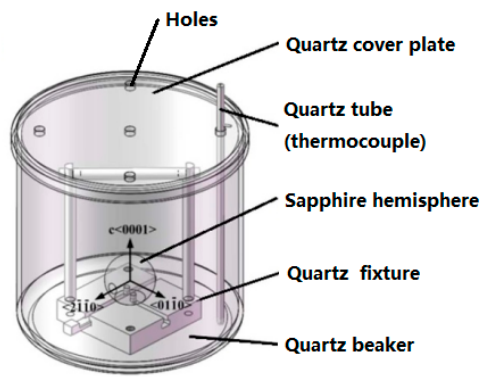
Figure 4. The schematic diagram of the wet etching device used to etch the hemisphere of sapphire.